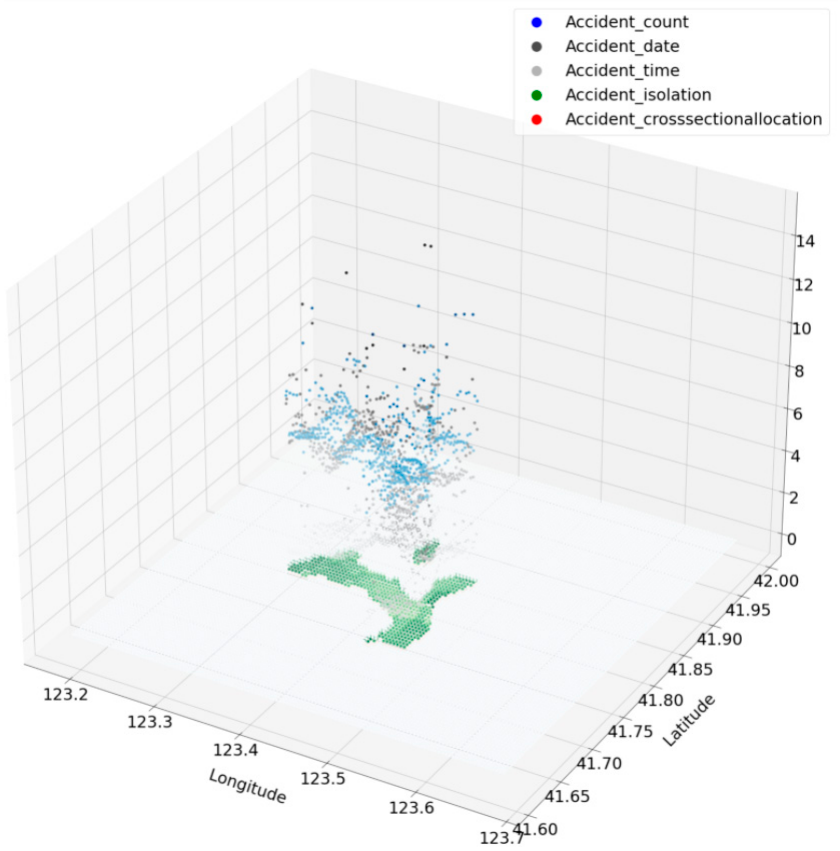
Figure 10. The spatial distribution of state value C t , s